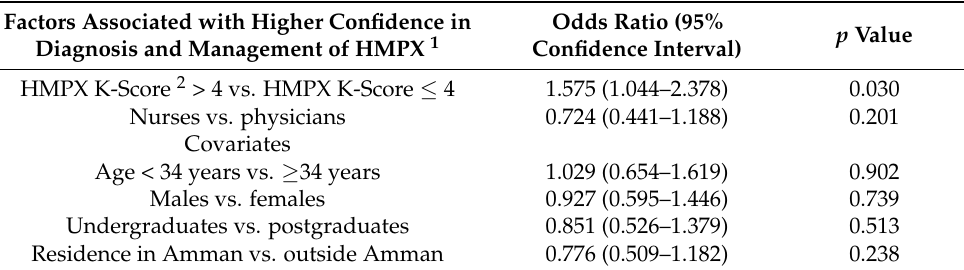
Table 2. Factors correlated with higher confidence in diagnosis and management of human monkey- pox (HMPX) among physicians and nurses who participated in the study ( n = 394). Factors Associated with Higher Confidence in Diagnosis and Management of HMPX 1